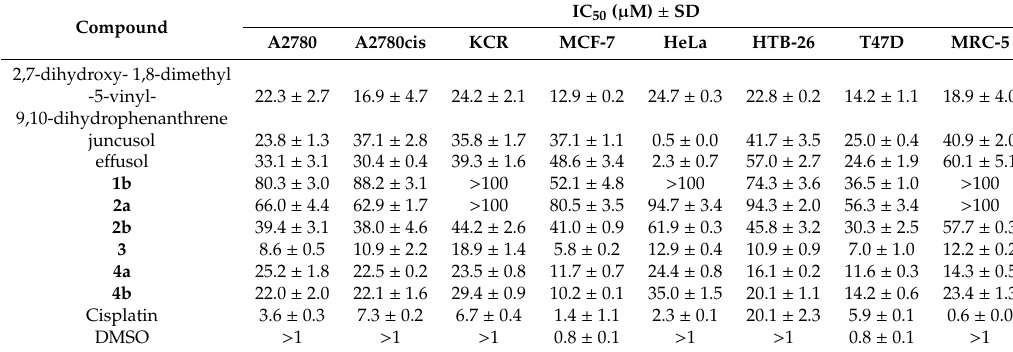
Table 3. IC 50 values of the